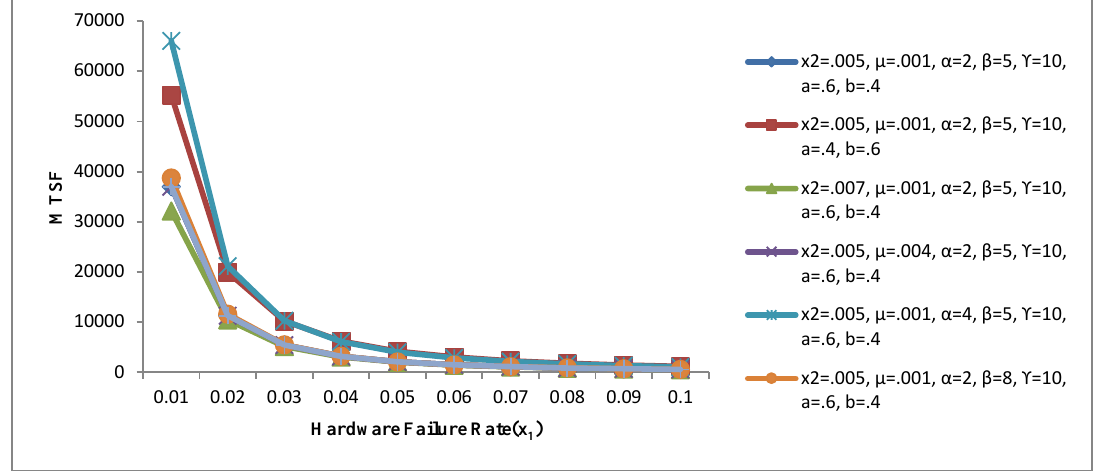
Figure 2. MTSF vs hardware failure rate ( 𝑥